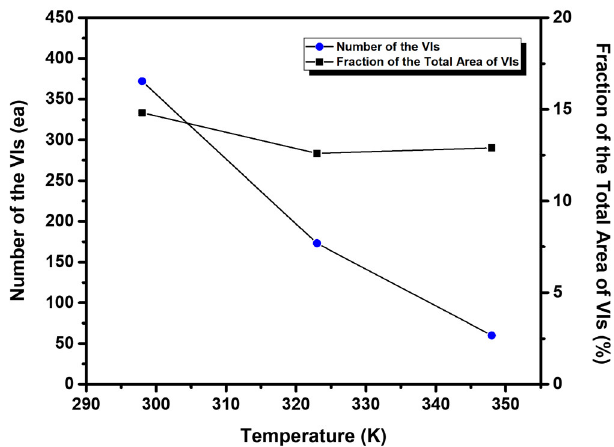
Figure 3. The number of VIs (circles) and the fraction of total area of the VIs (squares) for EG2 SAMs on Au(111) formed at 298 K, 323 K, and 348 K.